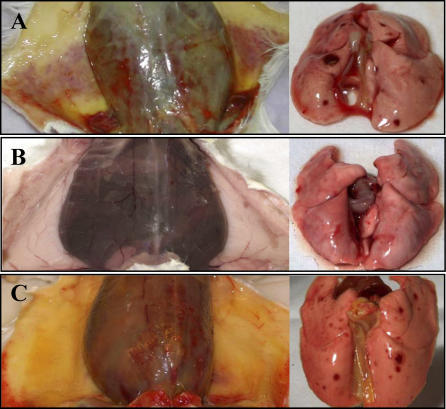
Gross Examination of Infected Guinea PigsLeft panel: Guinea pigs infected with the wild-type (A) and complemented strains (C) with clinical findings of jaundice and hemorrhages that are absent in guinea pigs infected with the mutant loa22− strain (B).Right panel: Lungs of a guinea pig infected with mutant loa22− did not exhibit macroscopic hemorrhage (B), in contrast with lungs of guinea pigs infected with the wild-type (A) and complemented strains (C). Tissues were observed 6 d post-inoculation.